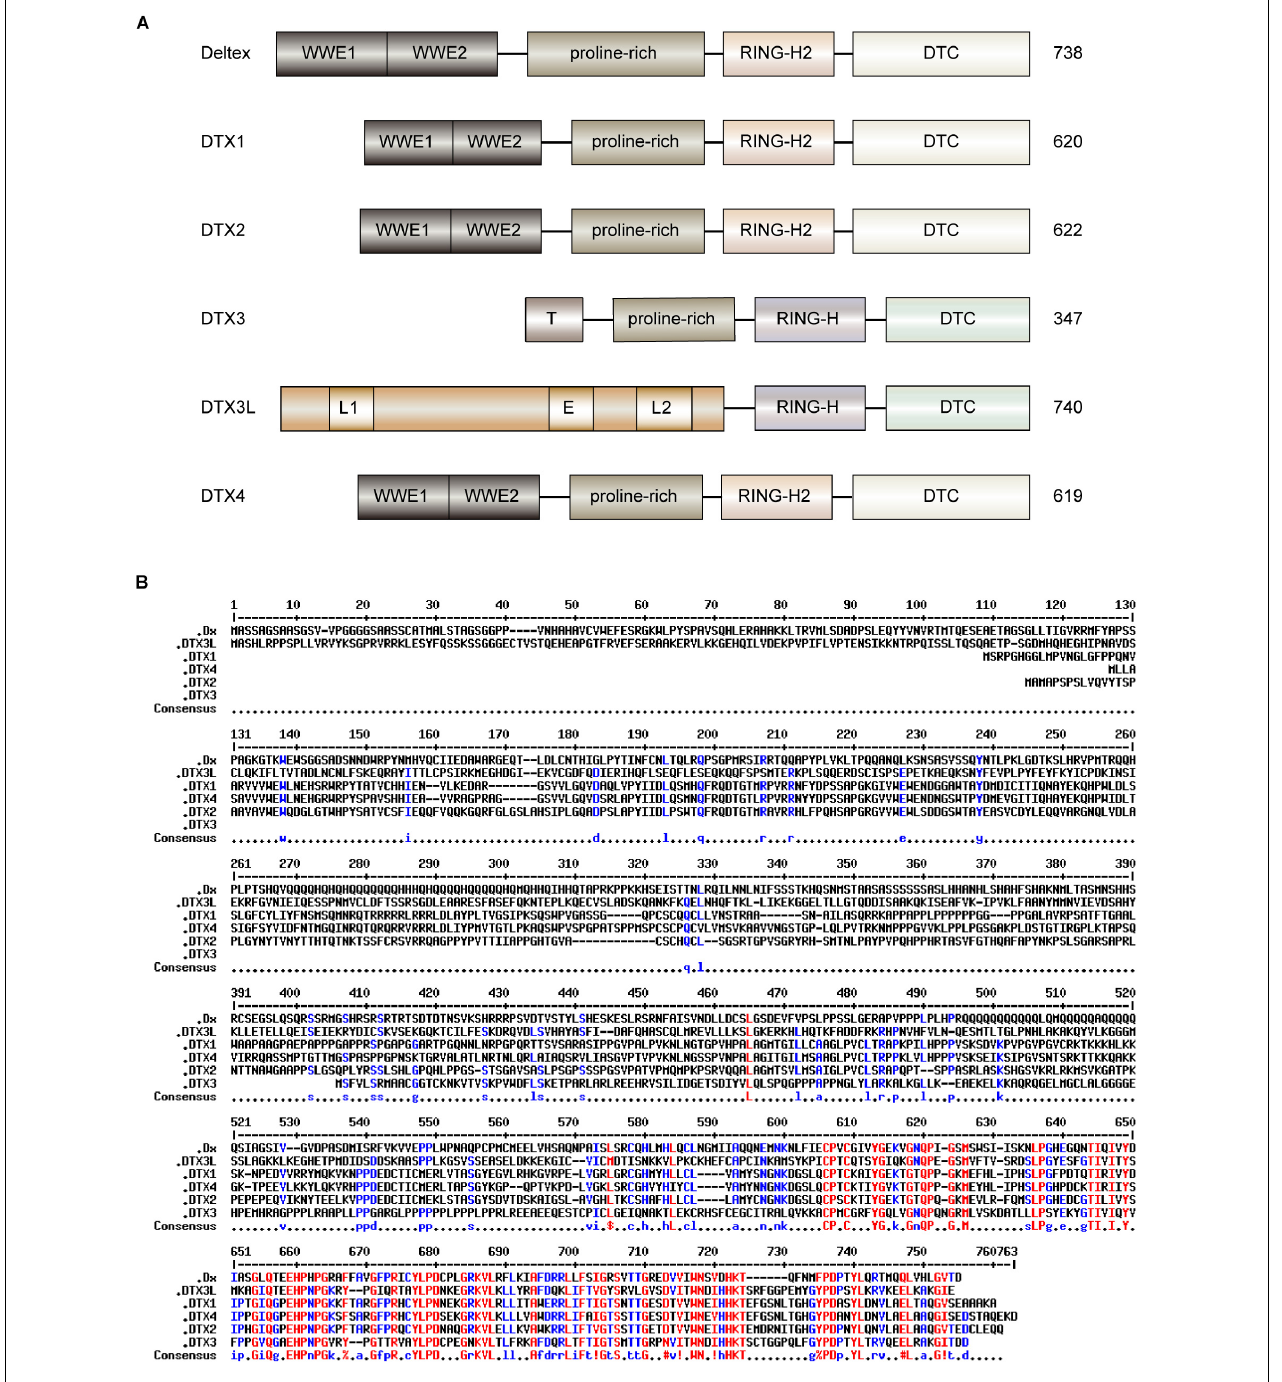
FIGURE 1 | Domain architectures and sequence alignment of human DTX family and Dx protein in Drosophila . (A) The domain architecture of human DTX family and Dx. The functional motifs of human DTX family members are highly analogous to those of Dx in Drosophila. The N-terminal WWE1 and WWE2 domains of Dx, DTX1, DTX2, and DTX4 can bind to the ankyrin repeats of the Notch receptor. DTX3 has a truncated unique N-terminal domain (T) that lacks the ability to bind to ankyrin repeats. The long N-terminal region of DTX3L is associated with nuclear localization signals (L1 and L2) and nuclear export signal (E). The proline-rich regions are similar, except for DTX3L. The Deltex C-terminal (DTC) domains are practically conserved in all DTX proteins. The RING domain of each C-terminal region is divided into classical RING-H2 domain (Dx, DTX1, DTX2, and DTX4) or non-classical RING-H domain (DTX3 and DTX3L). (B) The sequence alignment of human DTX family and Dx. The multiple sequence alignment was performed using hierarchical clustering (Corpet, 1988), and generated via the Multalin program (version 5.4.1) with a high consensus value of 90% and a low consensus value of 50%. The identical residues are shown in red, and similar residues are in blue. Consensus symbol of!: anyone of IV, $: anyone of LM, %: anyone of FY, and #: anyone of NDQEBZ.